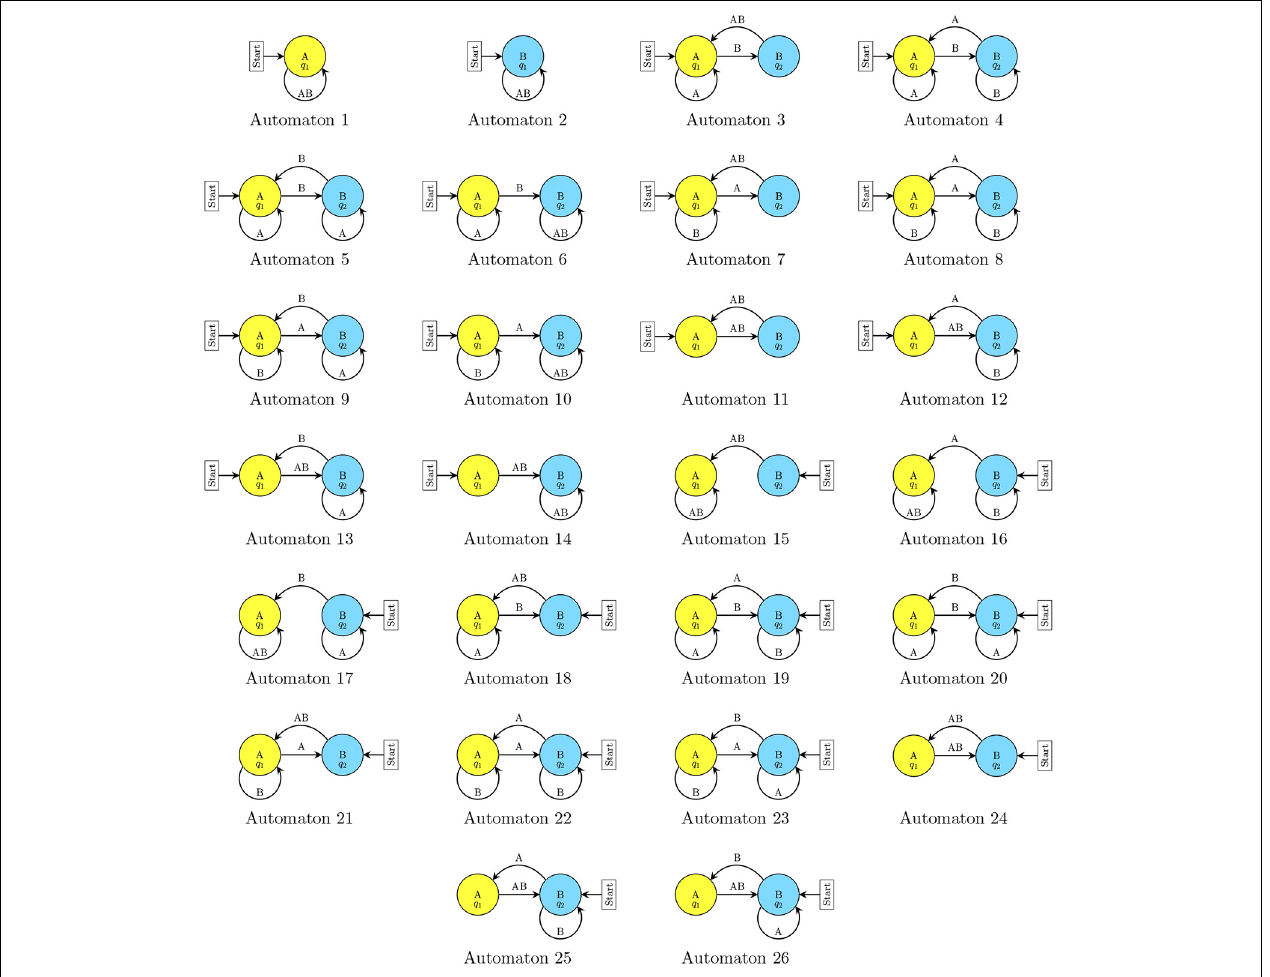
FIGURE 2 | One-state and two-state